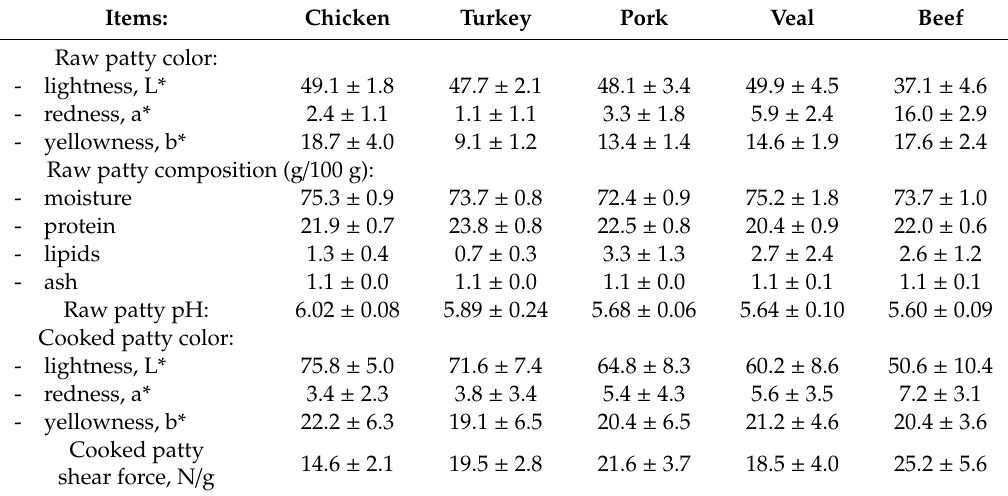
Table 1. Descriptive statistics (means ± SD) of characteristics of the meat sampled before (20 animals per species / category) and after processing and cooking (80 meat patties per species /